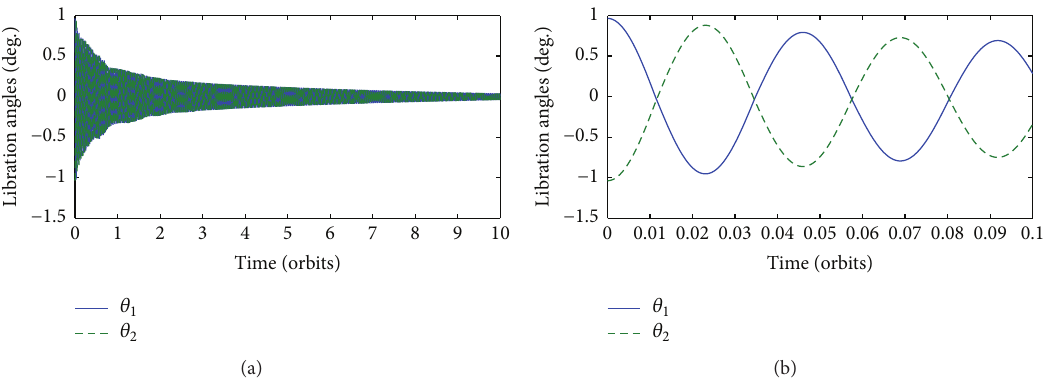
Figure 20: Libration angles from the formulations based on point 𝐶 by applying the SDRE control with 𝛼 = 0 for (a) the first 10 orbits and (b) the first 0.1 orbits.